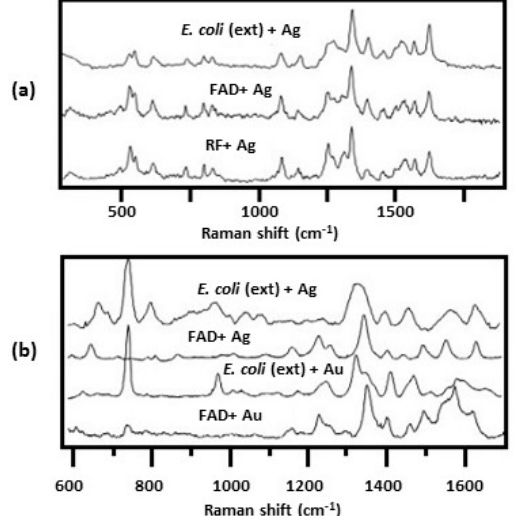
Figure 12. SERS spectra of E. coli coated with either an external Ag or Au colloid, FAD adsorbed on either Ag or Au, and RF adsorbed on Ag where spectra were obtained using: ( a ) 514 nm; and ( b ) 633 nm laser excitation [34]. Reproduced with permission from John Wiley and